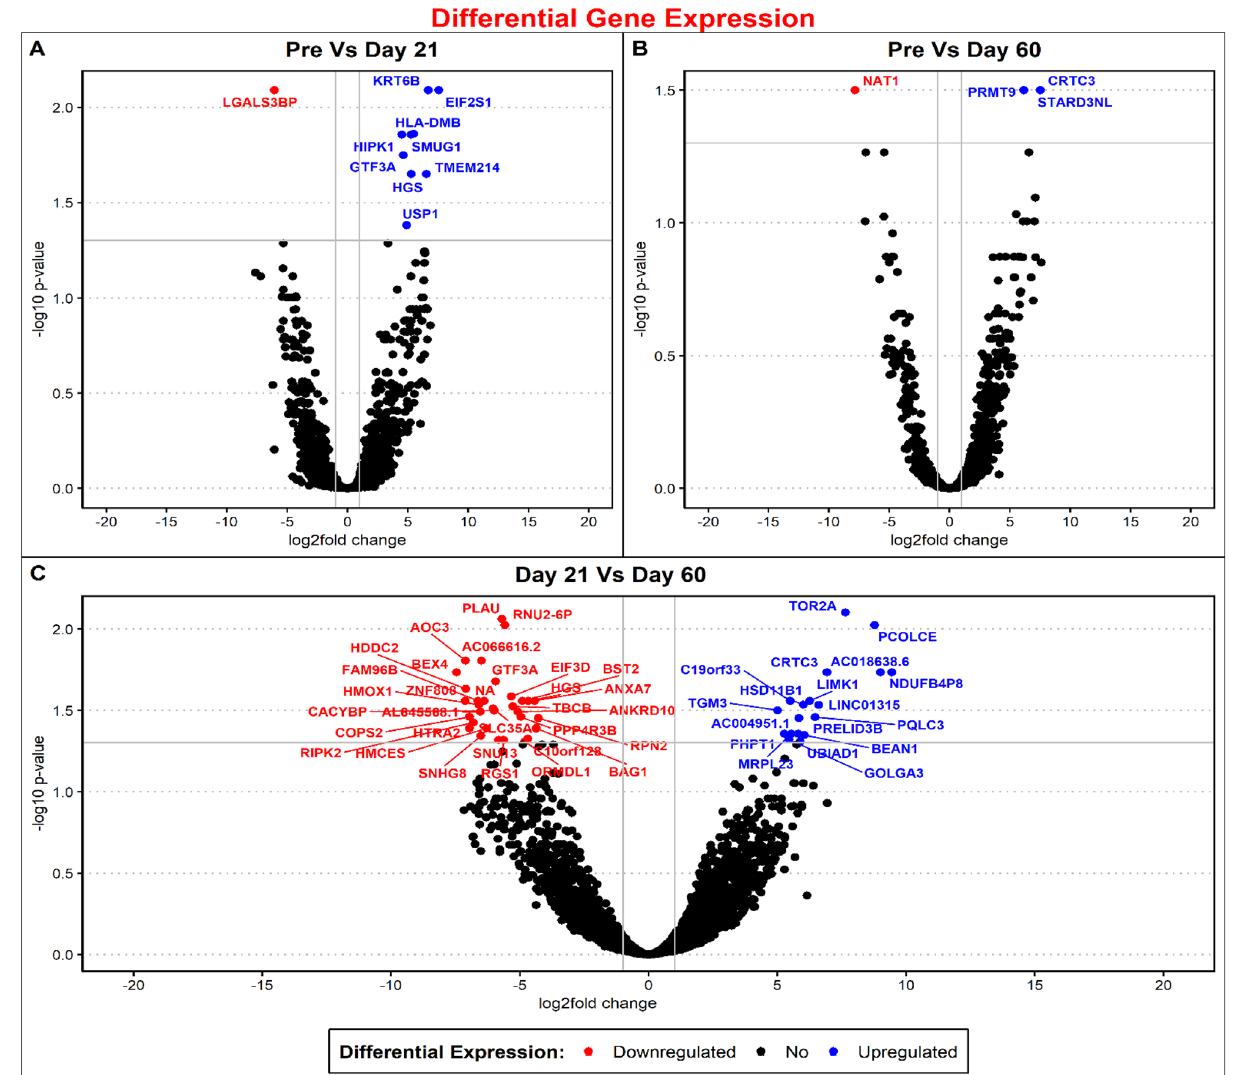
Figure 4. ( A – C ) Volcano plots to visualize the expression profile of the top differentially expressed genes sorted by their adjusted p-value by plotting their log2 transformed expression values. Downregulated DEGs are noted in red and upregulated DEGs are noted in